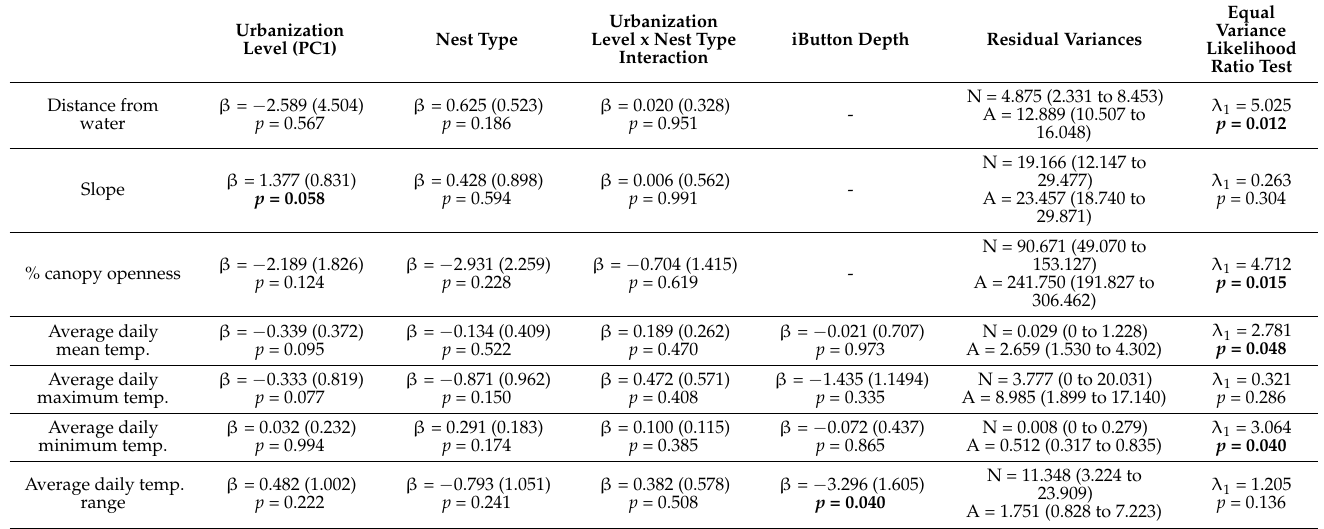
Table 4. Effects of urbanization, nest type (natural vs. artificial), and their interaction on microhabitat variables. iButton depth was only included in the analyses of temperature data. The effect size for nest type was calculated with the natural nest as the intercept/reference. The rightmost two columns indicate whether residual variance differed between natural (N) and artificial (A) nests, and if so, what the two separate variances are (natural nests listed first, artificial nests second). Estimates and either standard errors or 95% confidence intervals are indicated in parentheses. For residual variances, we report lower confidence interval limits of 0 when the CIs cannot exclude zero. Statistically significant p values are in bold